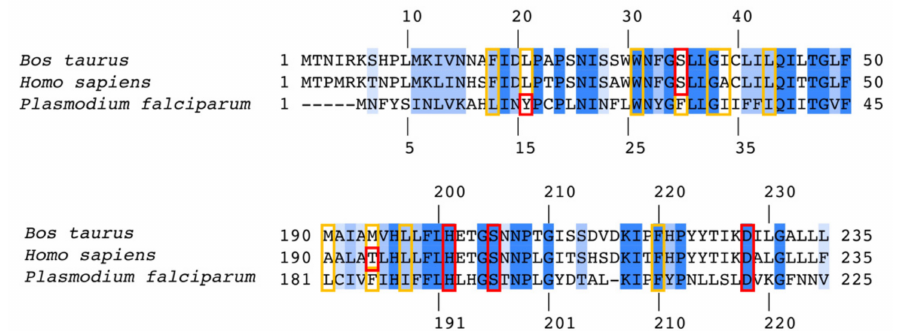
Figure 4. Sequence alignment between bovine, human, and P. falciparum cytochrome b showing conservation in the Q i site. Fully and partially conserved residues are colored in deep and light blue, respectively. The numbering shown at the top and bottom corresponds to bovine (human) and P. falci- parum sequences, respectively. The polar and non-polar residues interacting with 4(1H)-quinolones in crystal structures and docking models are highlighted in red and yellow boxes, respectively. Sequence identity between human and bovine cytochrome b is 93%.